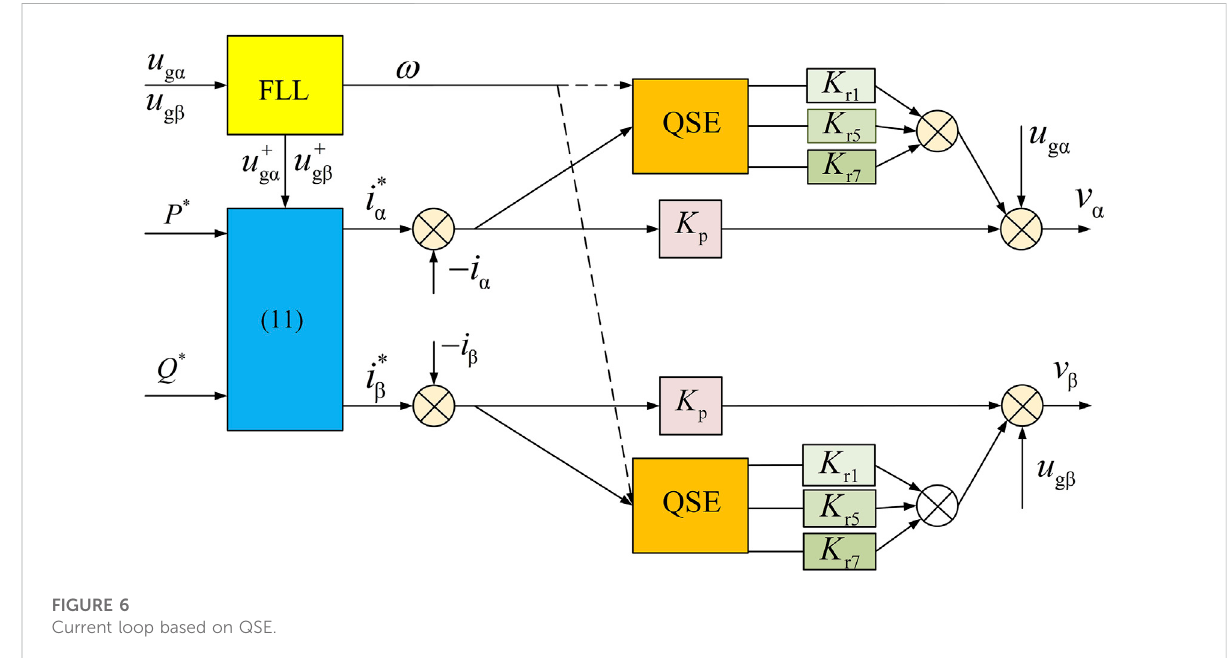
FIGURE 6 Current loop based on QSE.